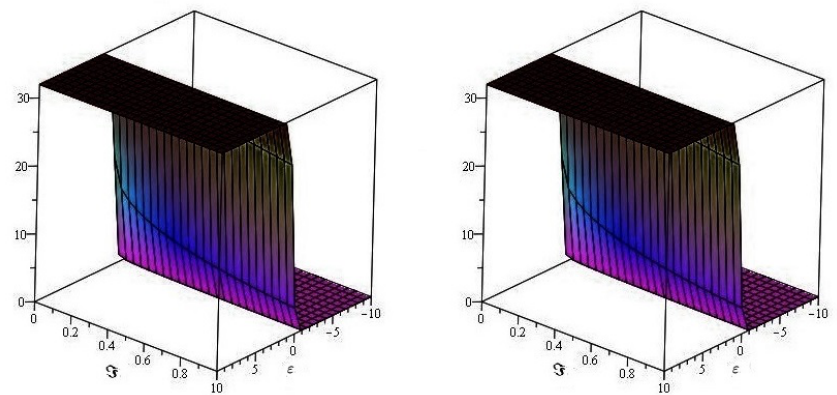
Figure 6. The actual and YDM solution of V ( ε , (cid:61) ) at ℘ = 1 of Example